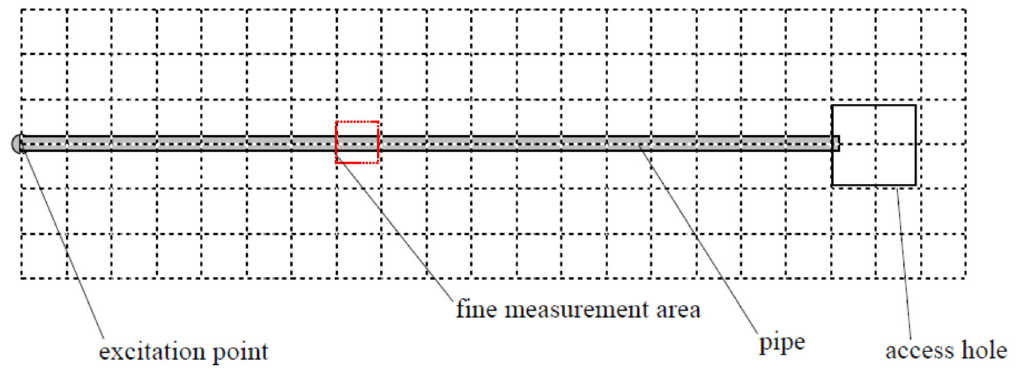
Figure A1. Grid of measurement points in [20].